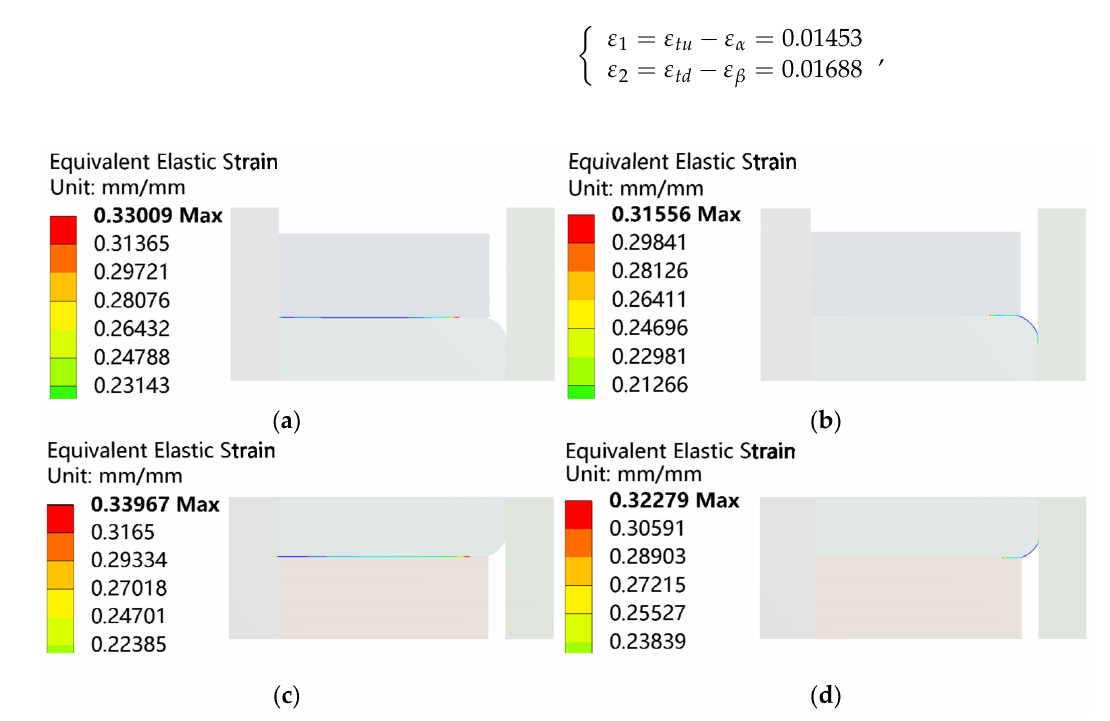
Figure 10. Diagram of maximum equivalent strain of the rubber packer after optimization. ( a ) At the upper end of the rubber packer; ( b ) On the chamfer at the upper end of the rubber packer; ( c ) At the lower end of the rubber packer; ( d ) On the chamfer at the lower end of the rubber